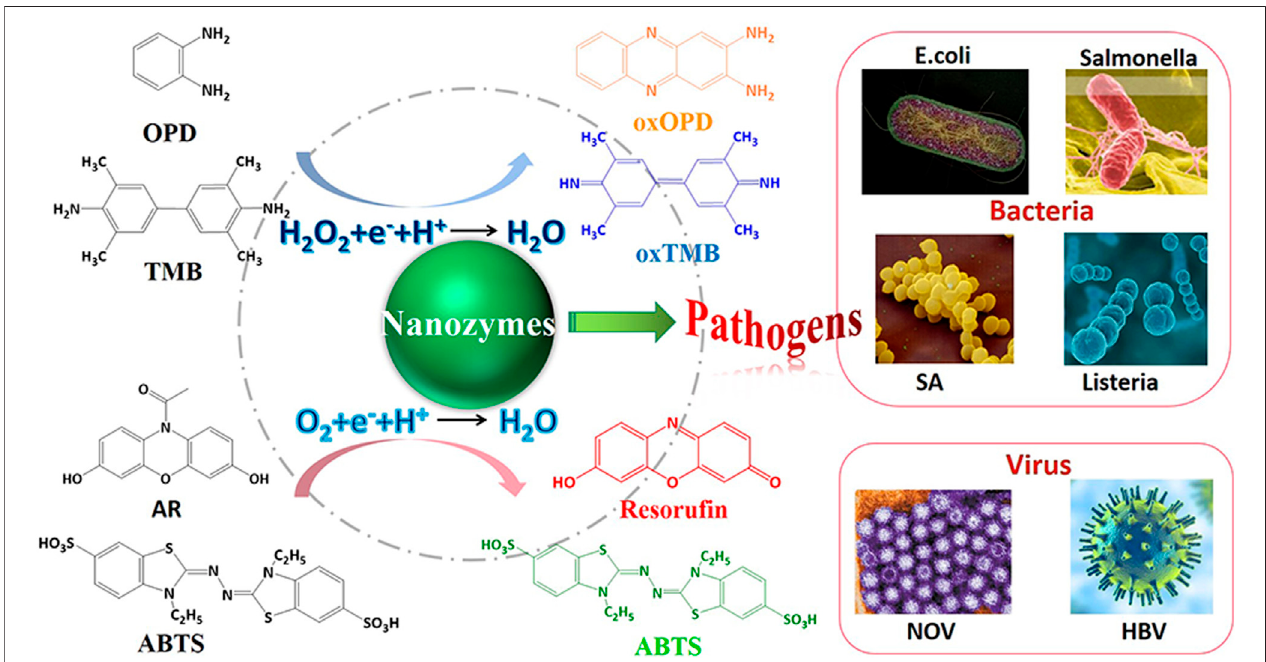
FIGURE 10 | Schematic illustration of analytical techniques for foodborne pathogenic microorganisms based on nanozymes-based colorimetric assays.